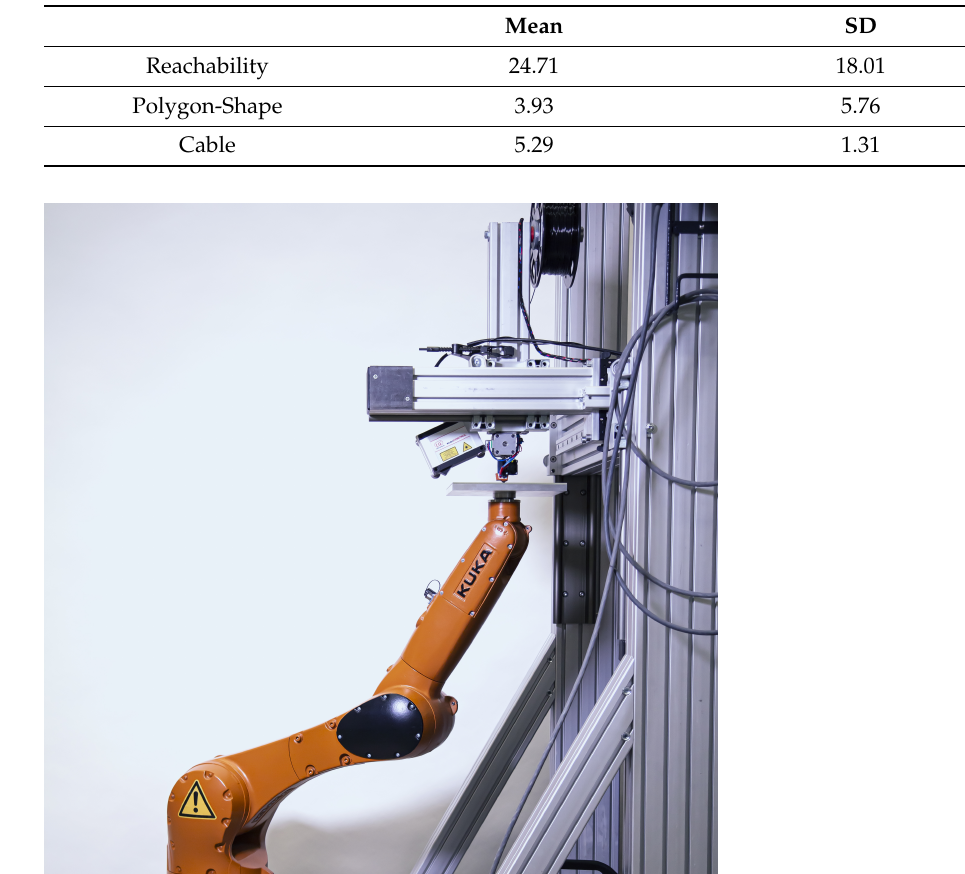
Table 4. Weights mean and standard deviation of the example in Figure 20.